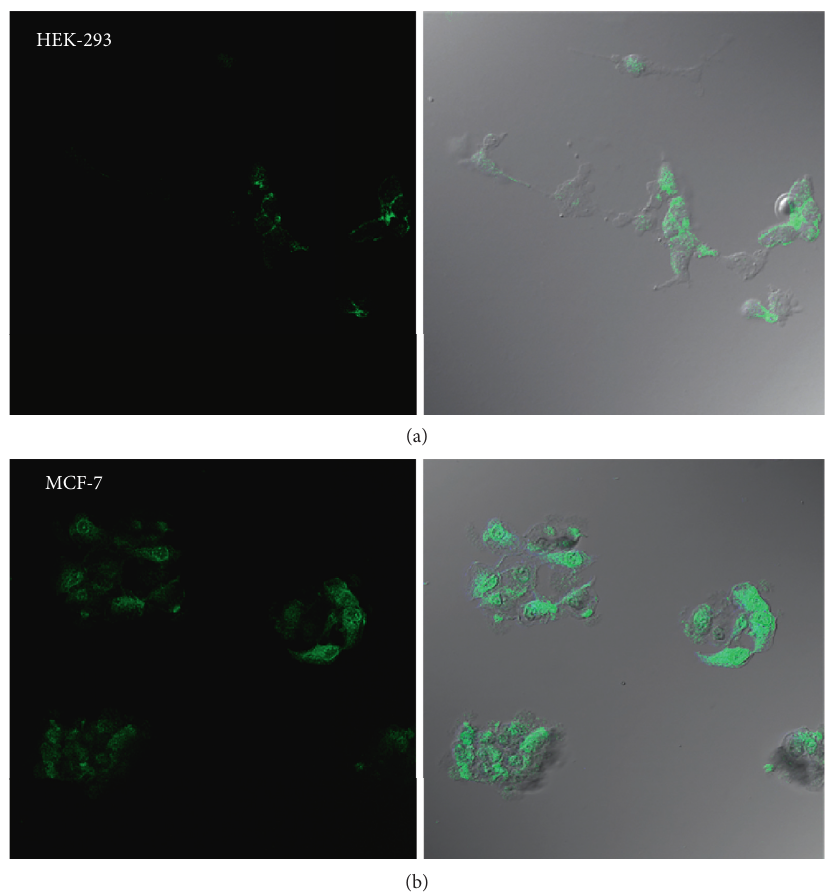
Figure 9: Confocal microscopy images of 2 about cellular uptake and the localization mode in healthy (HEK-293) (a) and breast cancer cells (MCF-7)